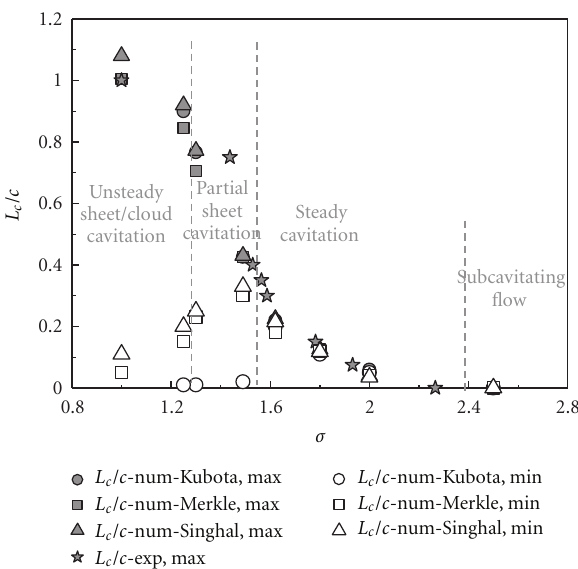
Figure 16: Comparison of the predicted and measured normalized maximum and minimum cavity lengths ( L c /c ) at various cavitation numbers. Re = 750,000, V ∞ = 5 m/s, α = 6 ◦ , and n = 3.